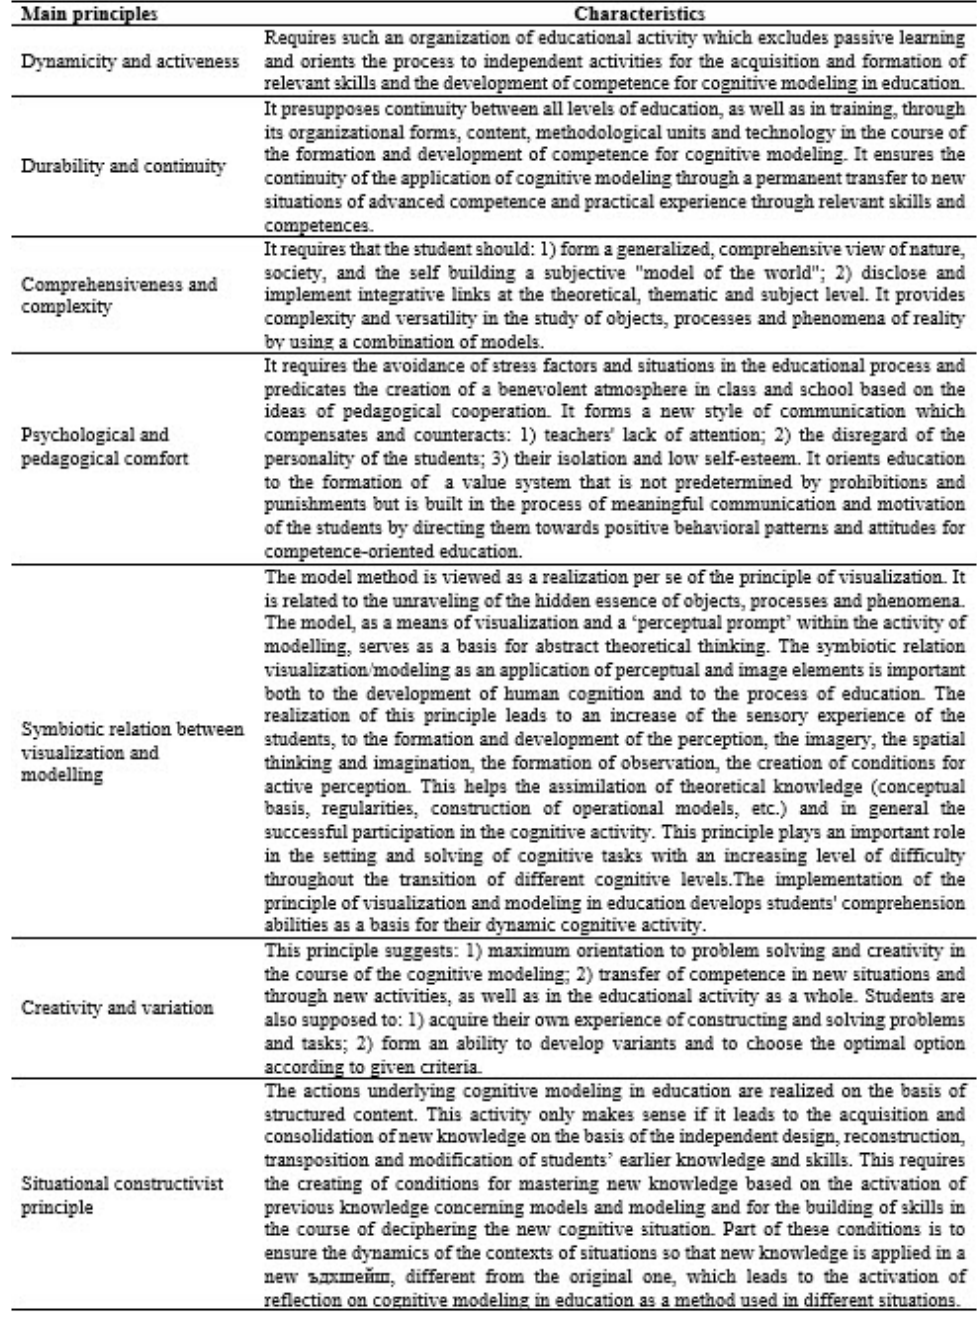
Table 1. General characteristics of the principles for development of competence for cognitive modeling in